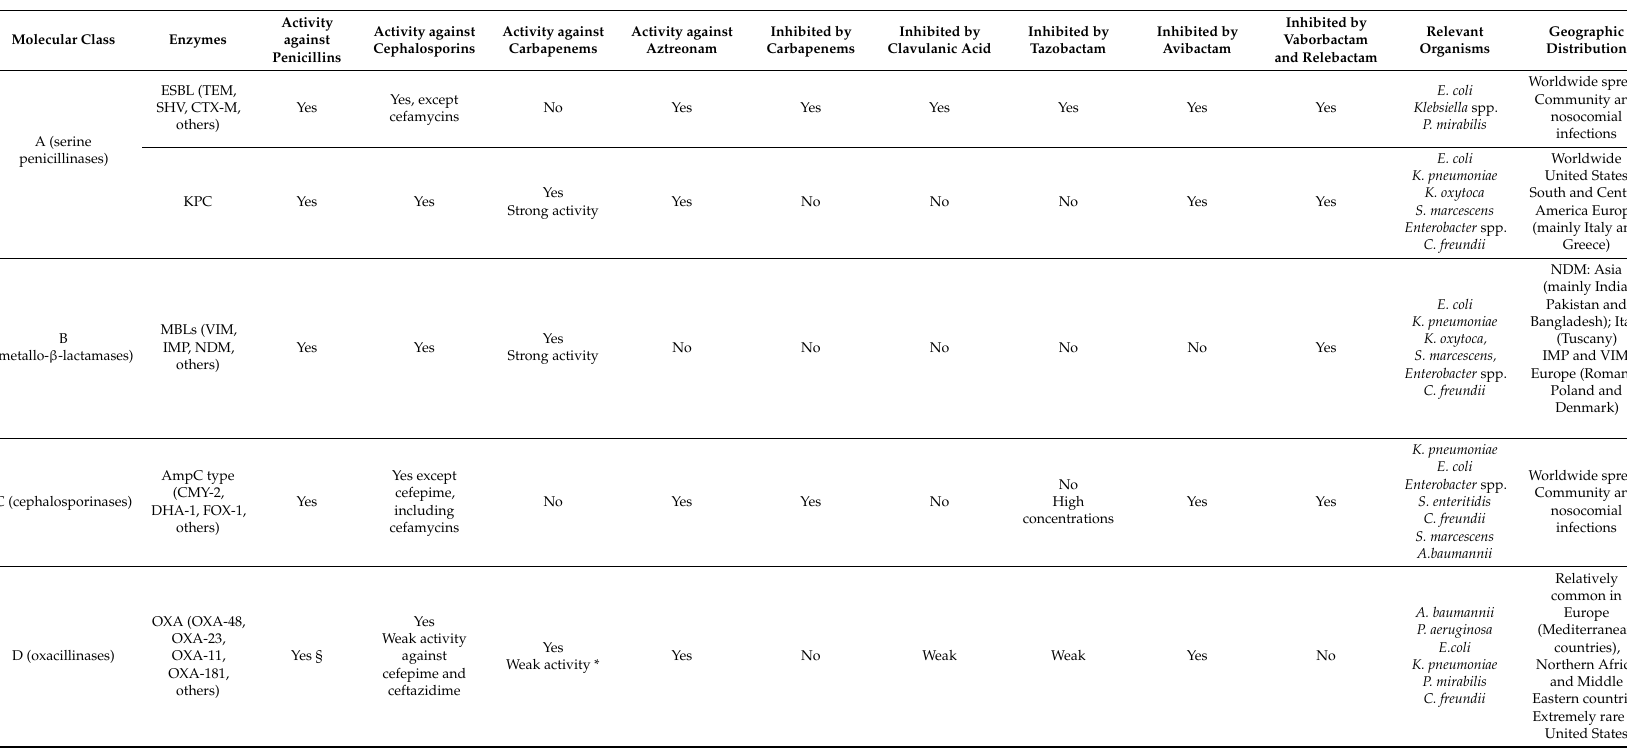
Table 1. Classification of most frequent extend ed-spectrum β -lactamases and carpapenemase, spectrum of activity, inhibition, relevant organism and geographic